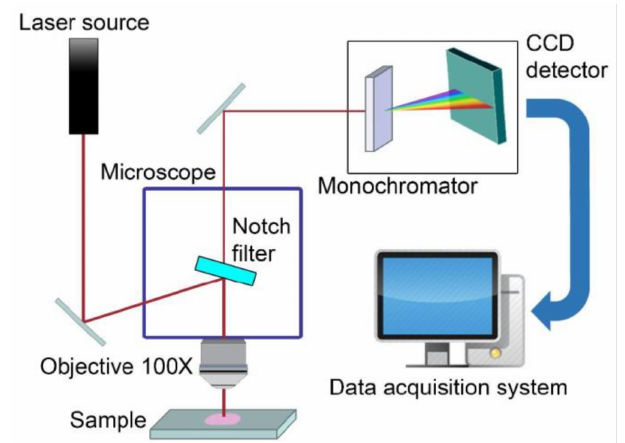
Figure 9. Experimental set-up for micro-Raman